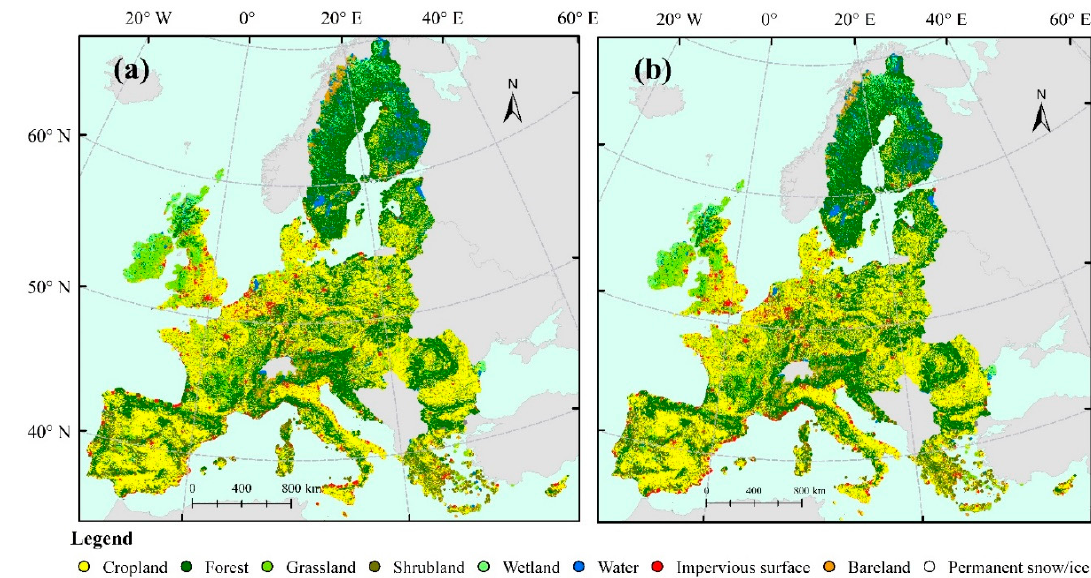
Figure 2. Spatial distribution of validation sample points: ( a ) sample points in 2010 and ( b ) sample points in 2015.